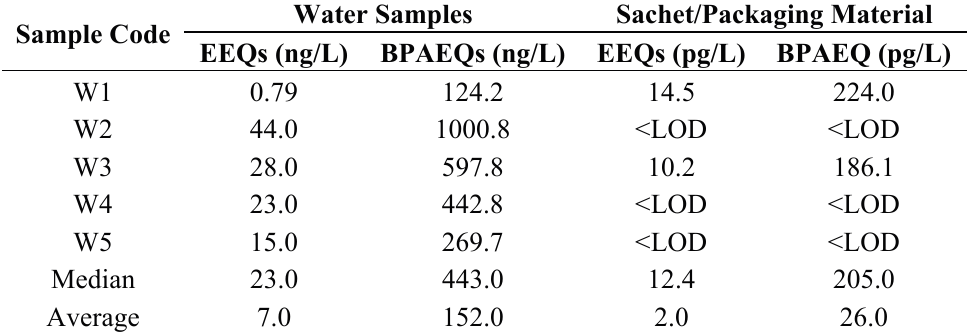
Table 6. Estradiol (EEQ) and bisphenol A (BPAEQ) equivalent concentrations of sachet water